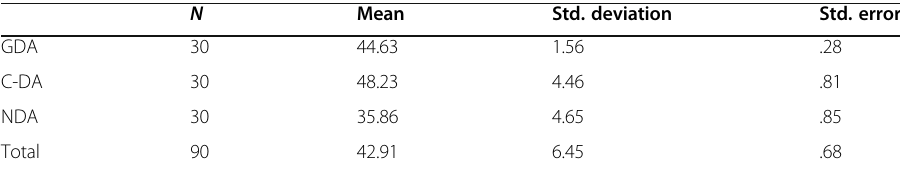
Table 9 Descriptive statistics for comparing the speaking complexity post-test scores of the GDA, C-DA, and N-DA learners N Mean Std.